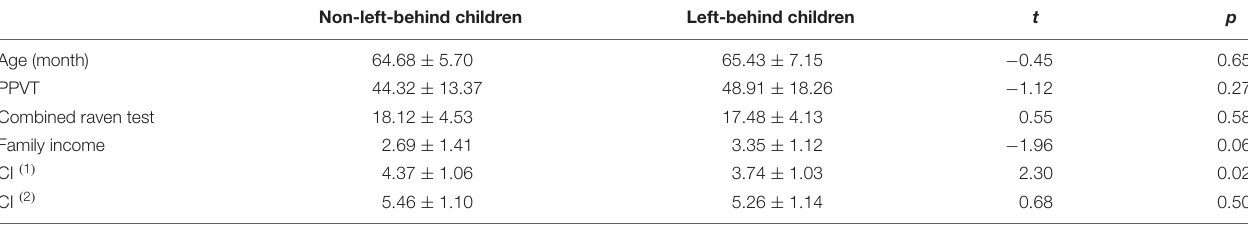
TABLE 1 | Demographic characteristics and differences of behavioral measures between left-behind and non-left-behind children. Non-left-behind children Left-behind children